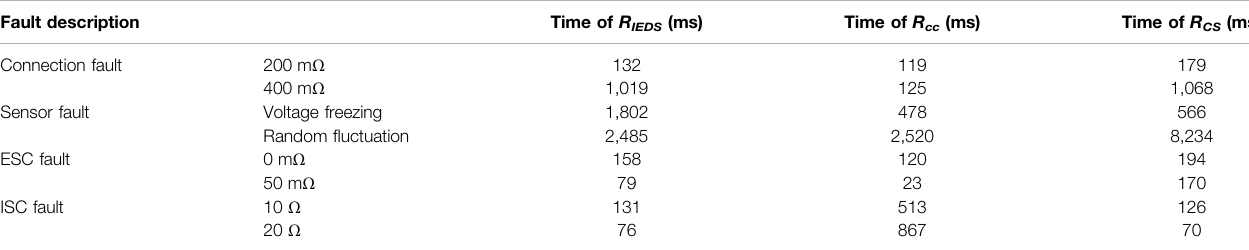
TABLE 2 | Diagnostic performance